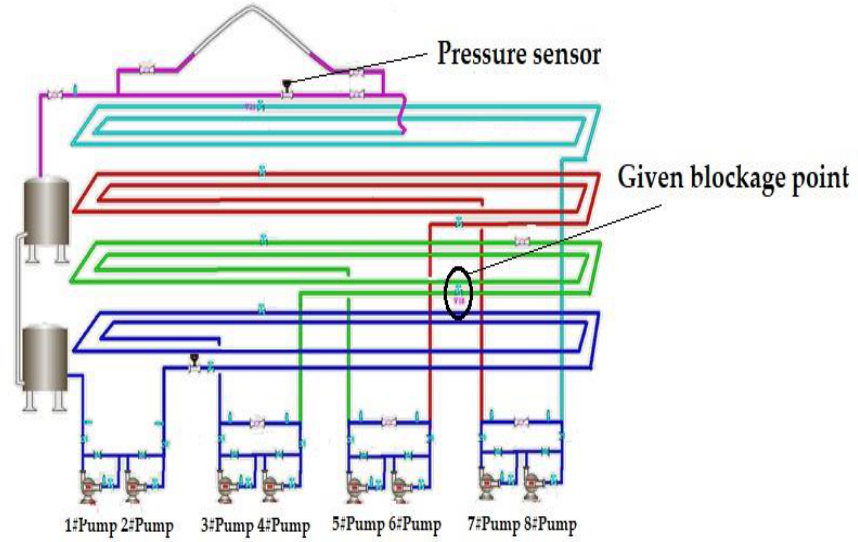
Figure 5. Schematic diagram of pipeline test bench.